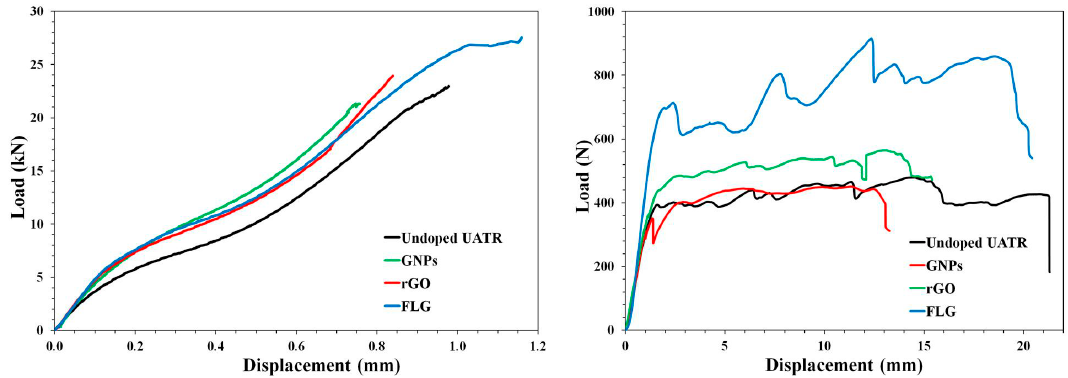
Figure 6. Mechanical properties of the tested laminated plates: ( a ) Tensile modulus (E t ); ( b ) Ultimate tensile strength ( σ t ); ( c ) Flexural modulus (E f ); ( d ) Ultimate flexural strength ( σ f ); ( e ) Charpy impact strength (a cU ). The dashed line represents the mean value obtained for an undoped UATR/Aramid composite with its corresponding error interval (light red band). GNPs do not show any significant improvement over the mechanical properties of the UATR-GNPs/aramid nanocomposite. As suggested in previous studies carried out with epoxy resin matrices, this may be due to the greater lateral size and number of layers in GNPs, which significantly reduces the effectiveness of graphenic material as a nanoreinforcing agent [17]. The large lateral size of the GNPs provides them with a natural tendency to wrinkle and fold back on themselves because of thermodynamic instabilities in the crystal lattice, causing a drastic reduction in their specific surface area while making it difficult for them to be effectively impregnated by the